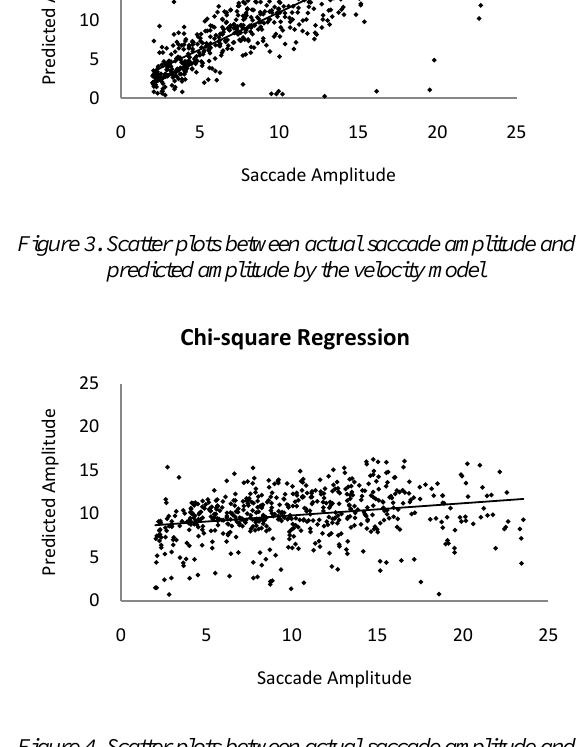
Figure 4. Scatter plots between actual saccade amplitude and predicted amplitude by the chi-square regression model